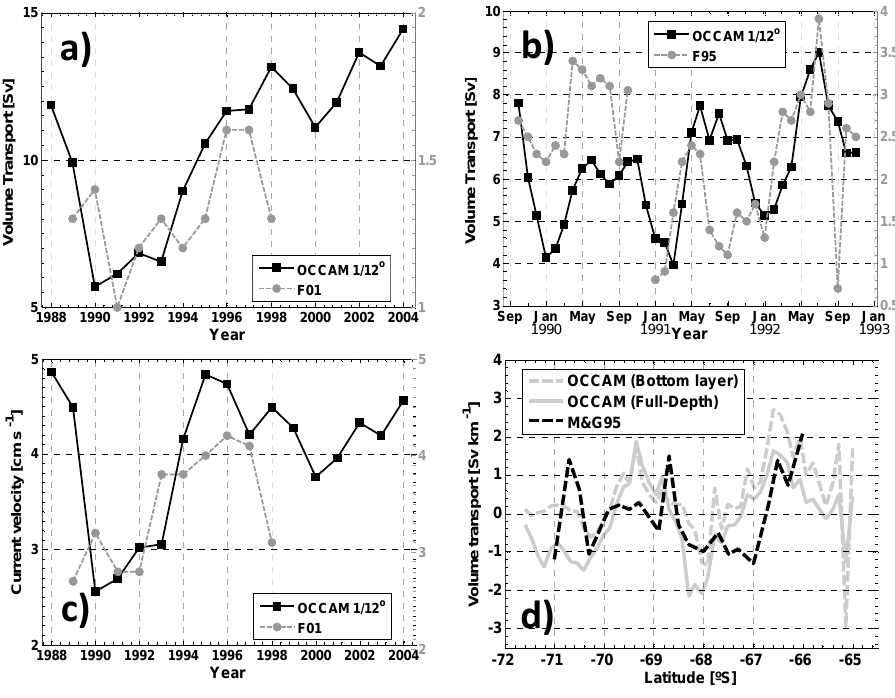
Fig. 6. Weddell Sea cross-slope section 1 bottom-layer volume transport (a) annual and (b) monthly average simulated by OCCAM (black line) and reported (grey line) by Fahrbach et al. (1995) = F95 and Fahrbach et al. (2001) = F01. (c) Same as described above, but for bottom- layer current velocity perpendicular to the bathymetry. (d) Northwestern Weddell Sea along-shelf-break section I full-depth and bottom volume transport vertically integrated and divided by the distance between the model grid points and observed hydrographic stations in a similar section to that observed by Muench and Gordon (1995) = M&G95 (see their Fig. 8). The values in (d) are normalized and represent the number of standard deviations from the overall